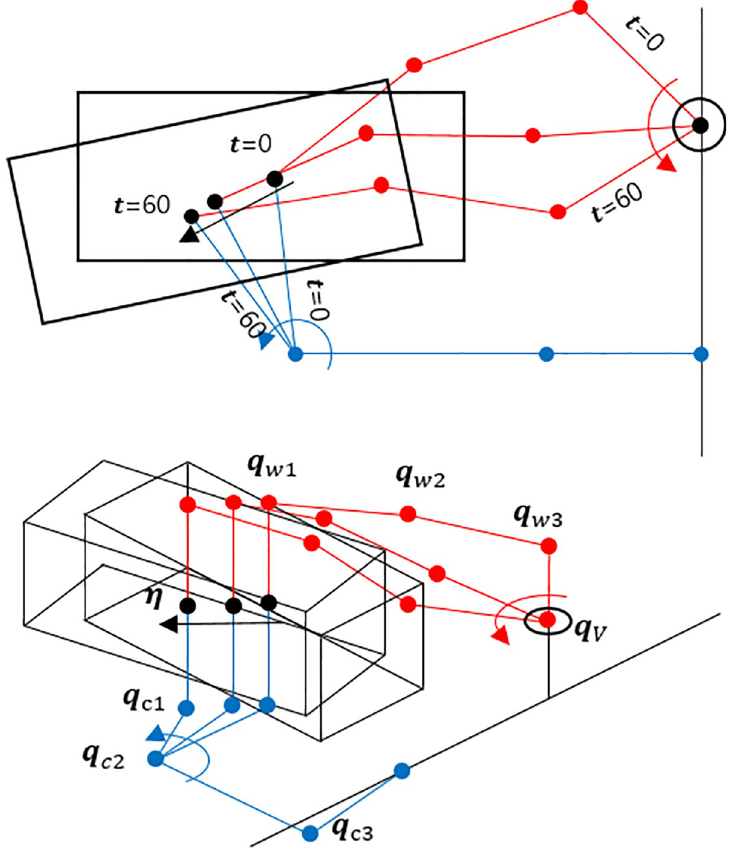
Fig 4. The trajectory of the